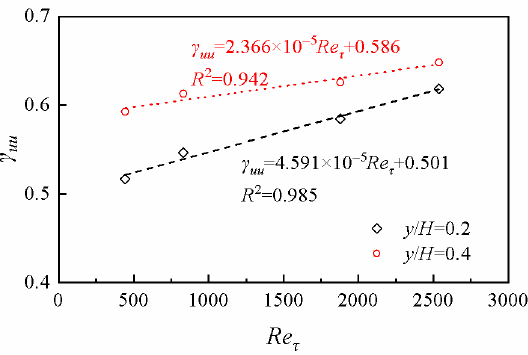
Figure 7. Streamwise kinetic energy fraction contributed by VLSMs versus the friction Reynolds number for y / H = 0.2 and 0.4.